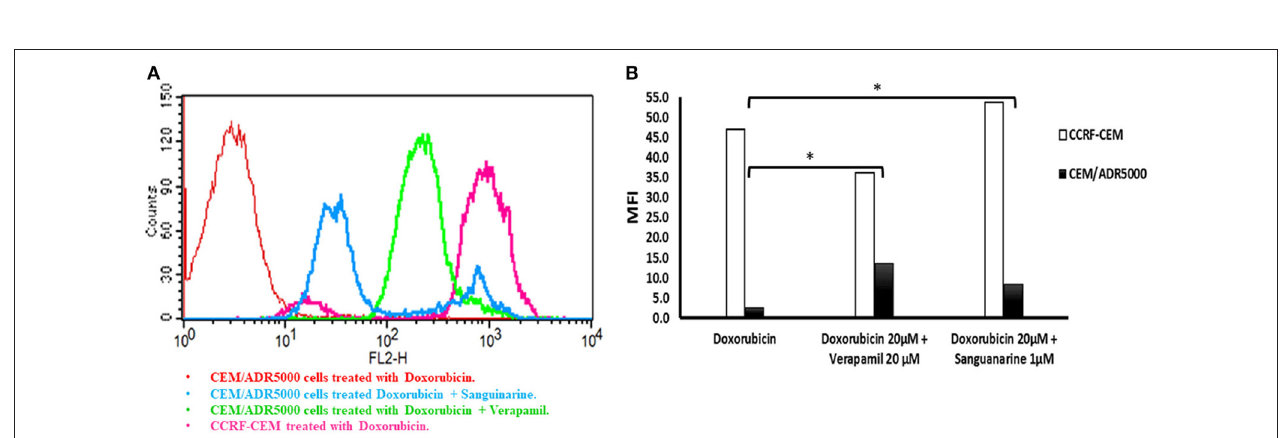
FIGURE 3 | Flow cytometry analysis of the effect of sanguinarine on doxorubicin uptake by cell line that overexpress P-gp in comparison of known transporter’s inhibitor, verapamil. (A) Histograms represent doxorubicin fluorescence intensity, CEM/ADR5000 cells treated with doxorubicin appear in red, CCRF-CEM cells treated with doxorubicin appears in pink, CEM/ADR5000 cells treated with doxorubicin in combination with sanguinarine and Verapamil appear in blue and light green respectively. (B) Bar diagram represent doxorubicin mean fluorescence intensity on cell line that overexpress P-gp, white bars represented sensitive cells, whereas resistant cells were represented by black bars. Mean fluorescence intensity (MFI) of doxorubicin has been measured by blue laser at excitation wave length 488 and emitted light was collected at 530/30 band pass. MFI values have been plotted on the y-axis against tested compounds on the x-axis. * P -value < 0.05.